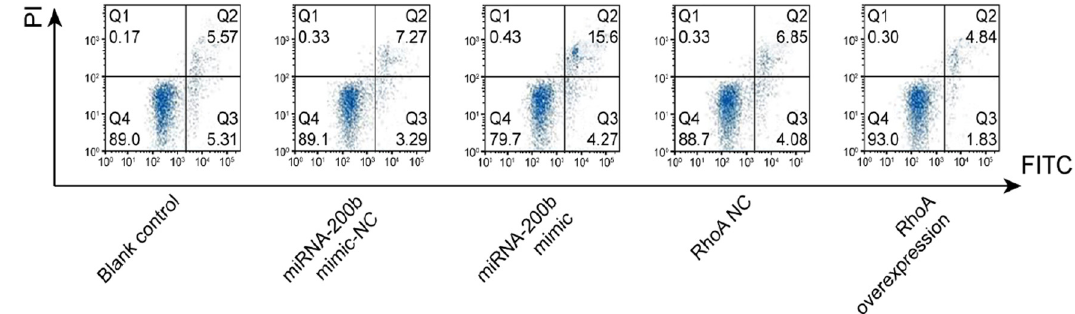
Figure 5: Apoptosis ability of Hela cells after transfection in each group.